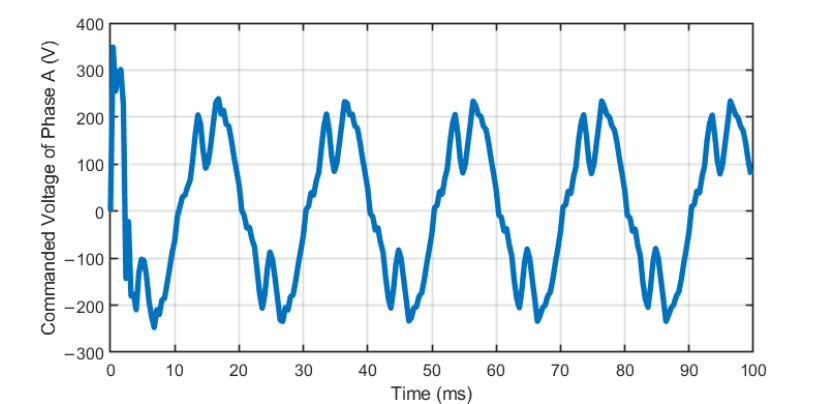
Figure 9. The commanded voltage of phase A in FOC drive.